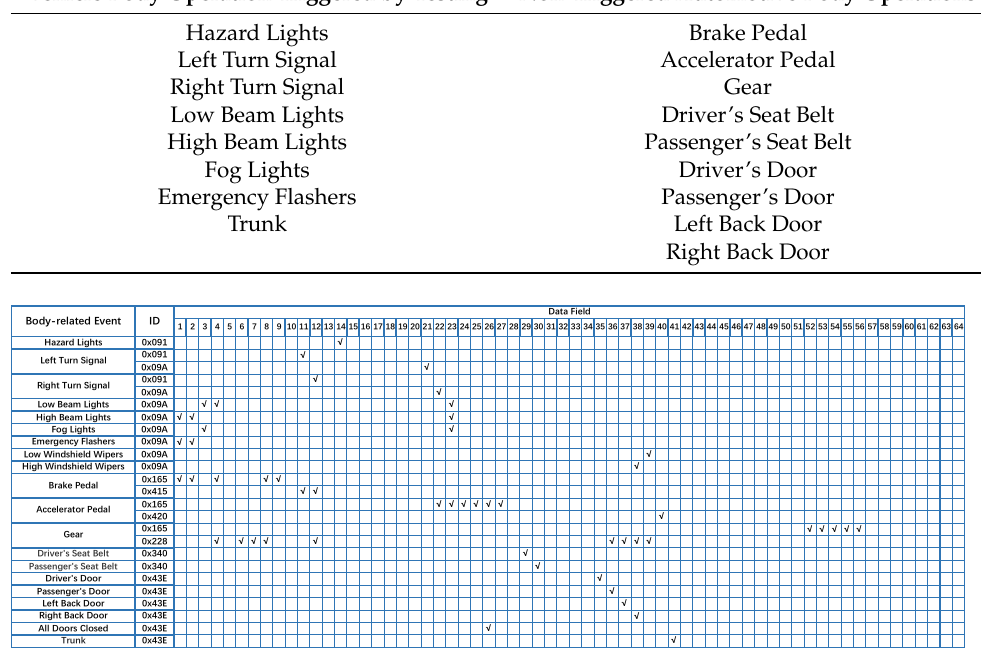
Figure 8. Reverse results of vehicle body-related CAN